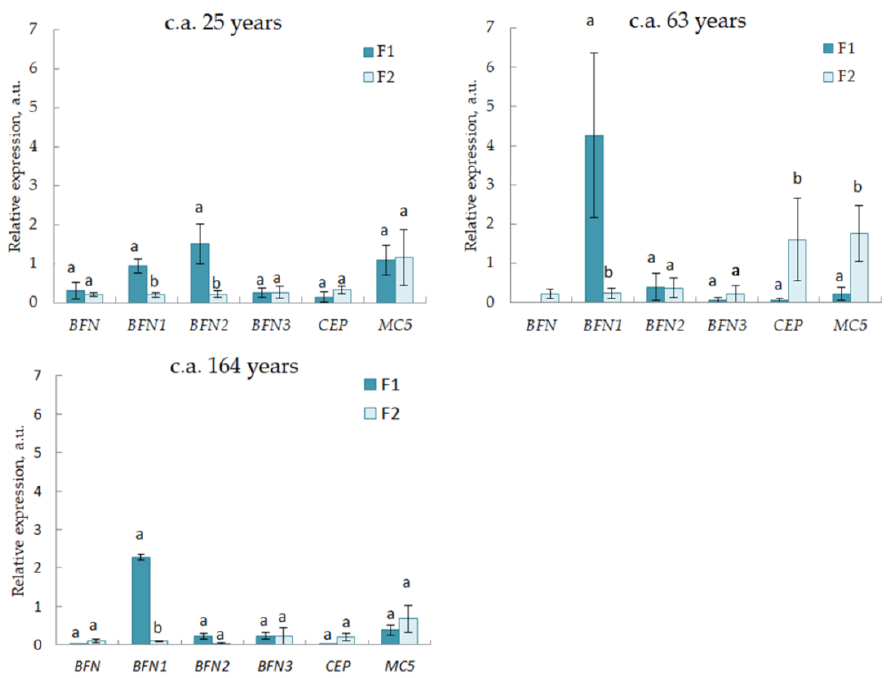
Figure 5. Relative expression (arbitrary units) of programmed cell death (PCD) genes in F1 and F2 of 25, 63, and 164 c.a. years Scots pine trees. Values represent the mean ± SE ( n = 5). The difference was considered significant if p < 0.05. Letters indicate differences between F1 and F2 for each gene.